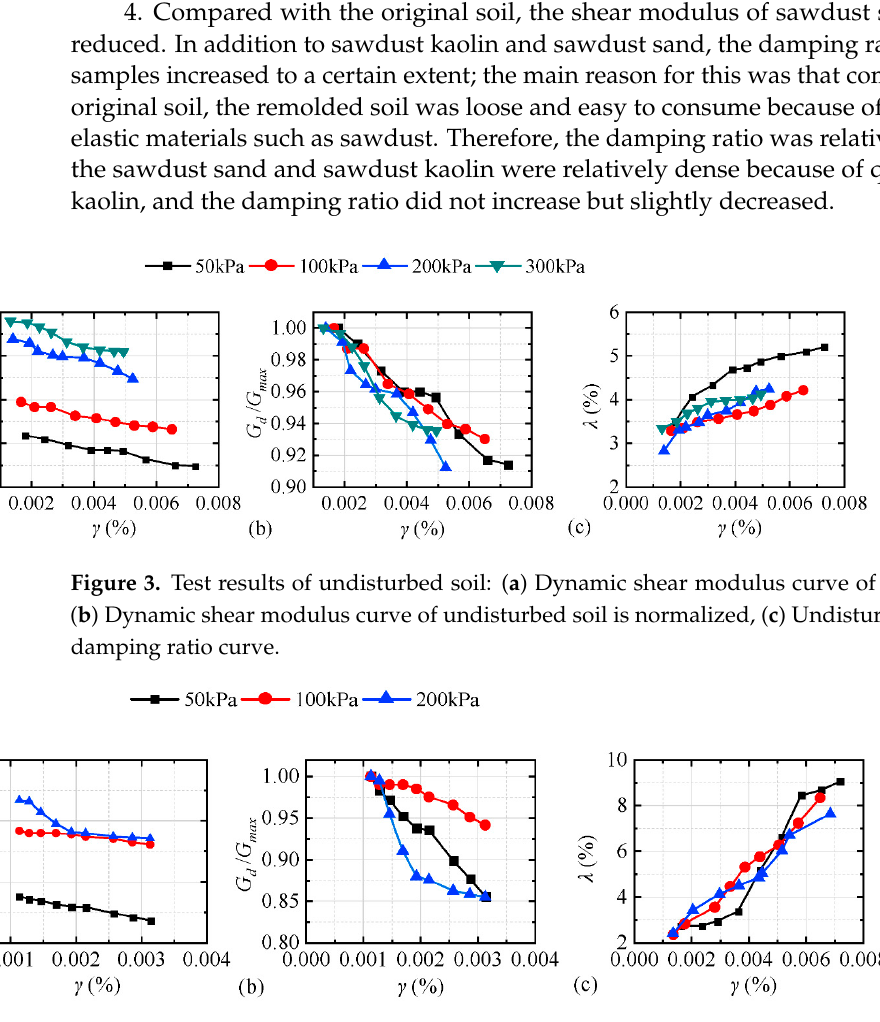
Figure 4. Test results of sawdust-soil: ( a ) Dynamic shear modulus curve of sawdust soil, ( b ) Normalized dynamic shear modulus curve of sawdust soil, ( c ) Curve of the dynamic damping ratio of sawdust soil.